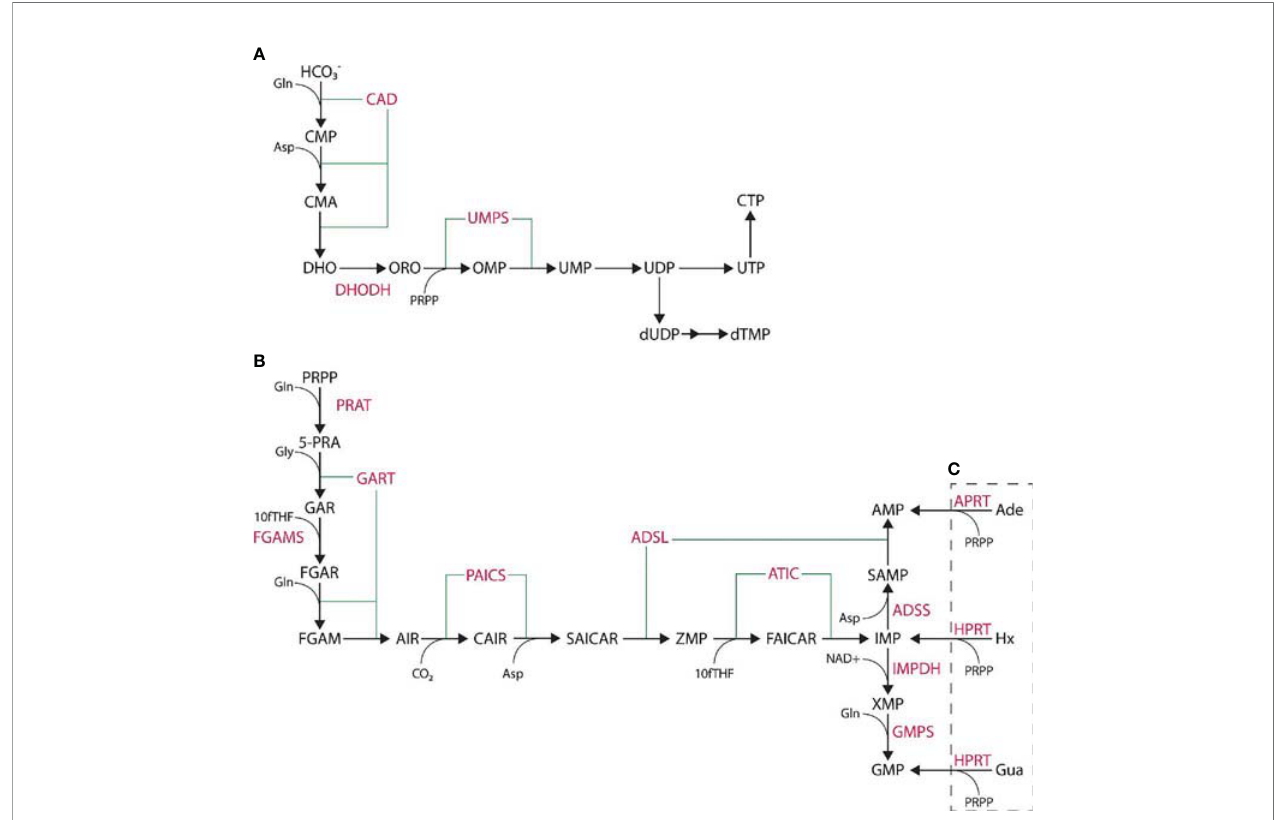
FIGURE 1 | De novo nucleotide synthesis pathways. (A) De novo pyrimidine synthesis pathway produces UMP via six steps catalyzed by three enzymes and is further processed to UTP, CTP, or dTMP. (B) De novo purine synthesis pathway produces IMP via ten steps catalyzed by six enzymes. IMP is further processed to AMP or GMP through two more steps. (C) Purine salvage synthesis utilizes adenine (Ade), hypoxanthine (Hx), or guanine (Gua) to generate phosphorylated nucleotides in a single step. Enzymes noted in pink while small molecules are in